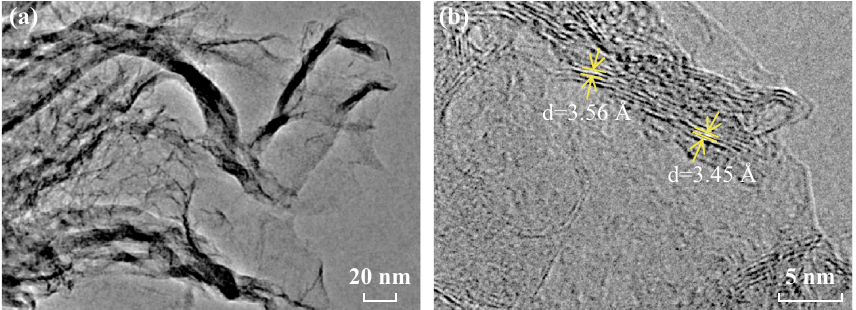
Fig. 2 a TEM and b high-resolution TEM images